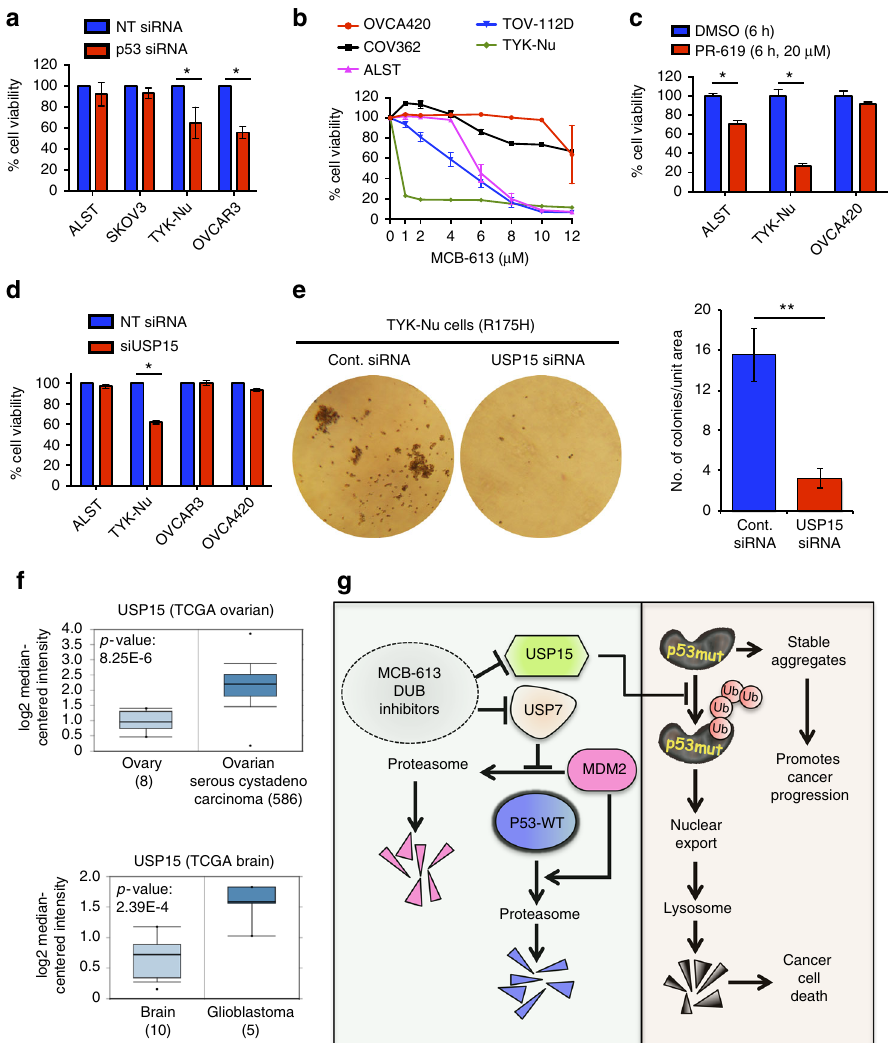
Fig. 7 USP15 depletion causes cancer cell death in ovarian cancer cells expressing p53-R175H. a p53 knockdown causes decreased viability in ovarian cancer cells expressing GOF mutp53, but not p53-WT and p53-null cells. Values are normalized mean ± s.e.m. ( n = 3; * p -value < 0.05). b Ovarian cancer cells expressing p53-R175H (TYK-Nu and TOV-112D) are more sensitive to MCB-613 than ALST (p53-WT), OVCA420 (p53-R273H), and COV362 (p53- Y220C). Values are normalized mean ± s.e.m. ( n = 3). c TYK-Nu cells are more sensitive to PR-619 compared with ALST and OVCA420 cells. Values are normalized mean ± s.e.m. ( n = 3; * p -value < 0.05). d Effect of USP15 knockdown on cell viability in ovarian cancer cells carrying different p53 mutation status. Values are normalized mean ± s.e.m. ( n = 3; * p -value = 0.0164). e USP15 knockdown signi fi cantly reduced the anchorage-independent growth of TYK-Nu cells (p53-R175H). Values are normalized mean ± s.d. ( n = 4; ** p -value = 0.006). f Data retrieved from Oncomine showing elevated USP15 mRNA levels in multiple cancers from previously published datasets 29,39 – 42 . g Schematic showing that different pathways regulate the stability of p53-R175H and p53-WT in ovarian cancer cells. MCB-613 and DUB inhibitors, such as NSC632839 and PR-619 caused selective depletion of the GOF p53 mutant p53- R175H, while causing slight increase in p53-WT levels. While inhibition of USP15 by these small molecules or siRNA resulted in increased ubiquitination and lysosome-mediated turnover of p53-R175H, it had no effect on p53-WT levels. In contrast, USP7 depletion caused MDM2-mediated stabilization